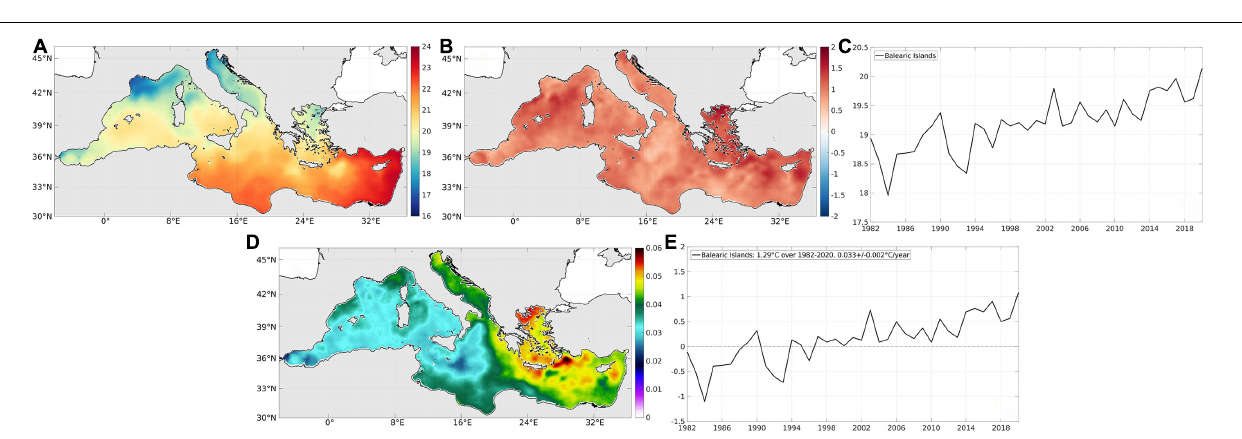
FIGURE 2 | Illustrations for SST (in ◦ C): daily means on 31-December-2020 (A–C) and monthly means in December 2020 (D–F) : 2D maps of SST (A,D) and SSTA (B,E) , and time series of SST averaged in the Balearic Islands since 2017 (C,F) .